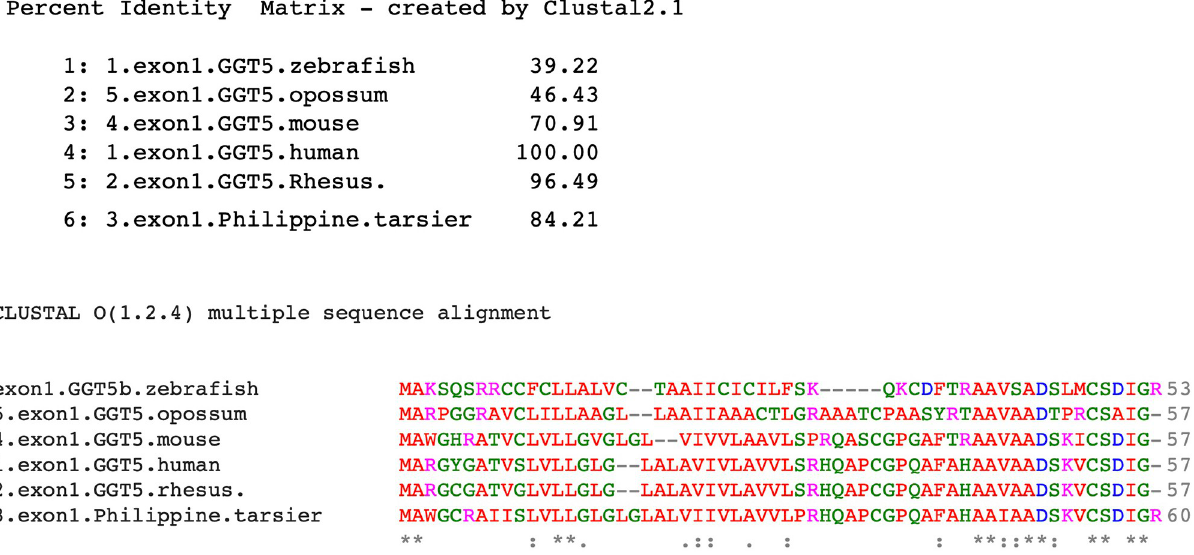
Fig 4. Alignment of amino acid sequences of exon 1 from GGT5 proteins from various species. Top. The percent identities between the human exon 1 and other species. Bottom. Amino acid sequences alignment showing tinvariant aa residues with � . Aligned by Clustal2.1 (https://www.ebi.ac.uk/